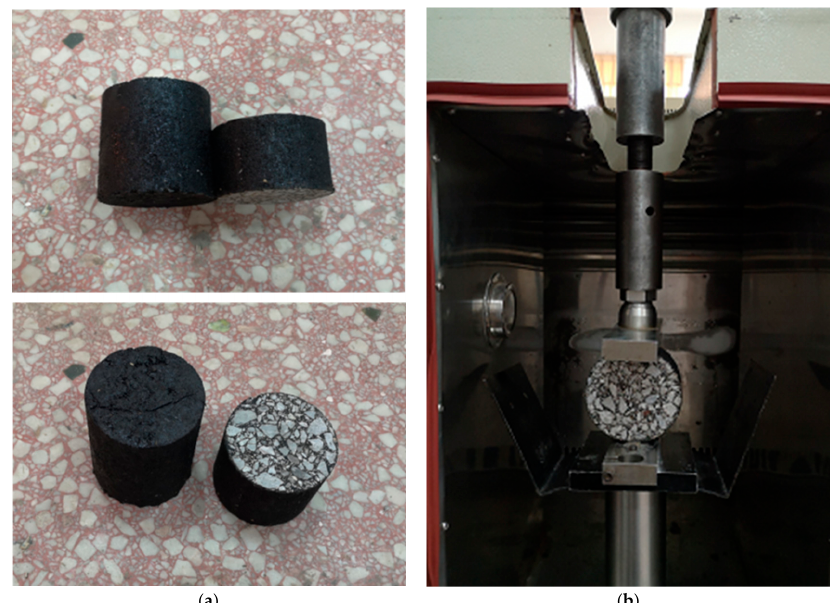
Figure 4. Indirect tensile test specimen and test drawing: ( a ) Rotary compacted cylindrical specimen; ( b ) Indirect tensile test chart.